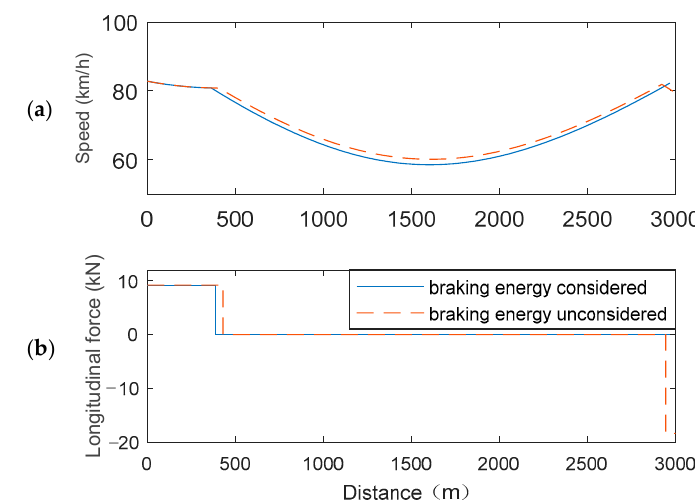
Figure 6. Optimum speed profile and its corresponding control inputs; time factor σ = 10, duration t f = 158 s/155 s. ( a ) Speed profile; ( b ) control input profile.